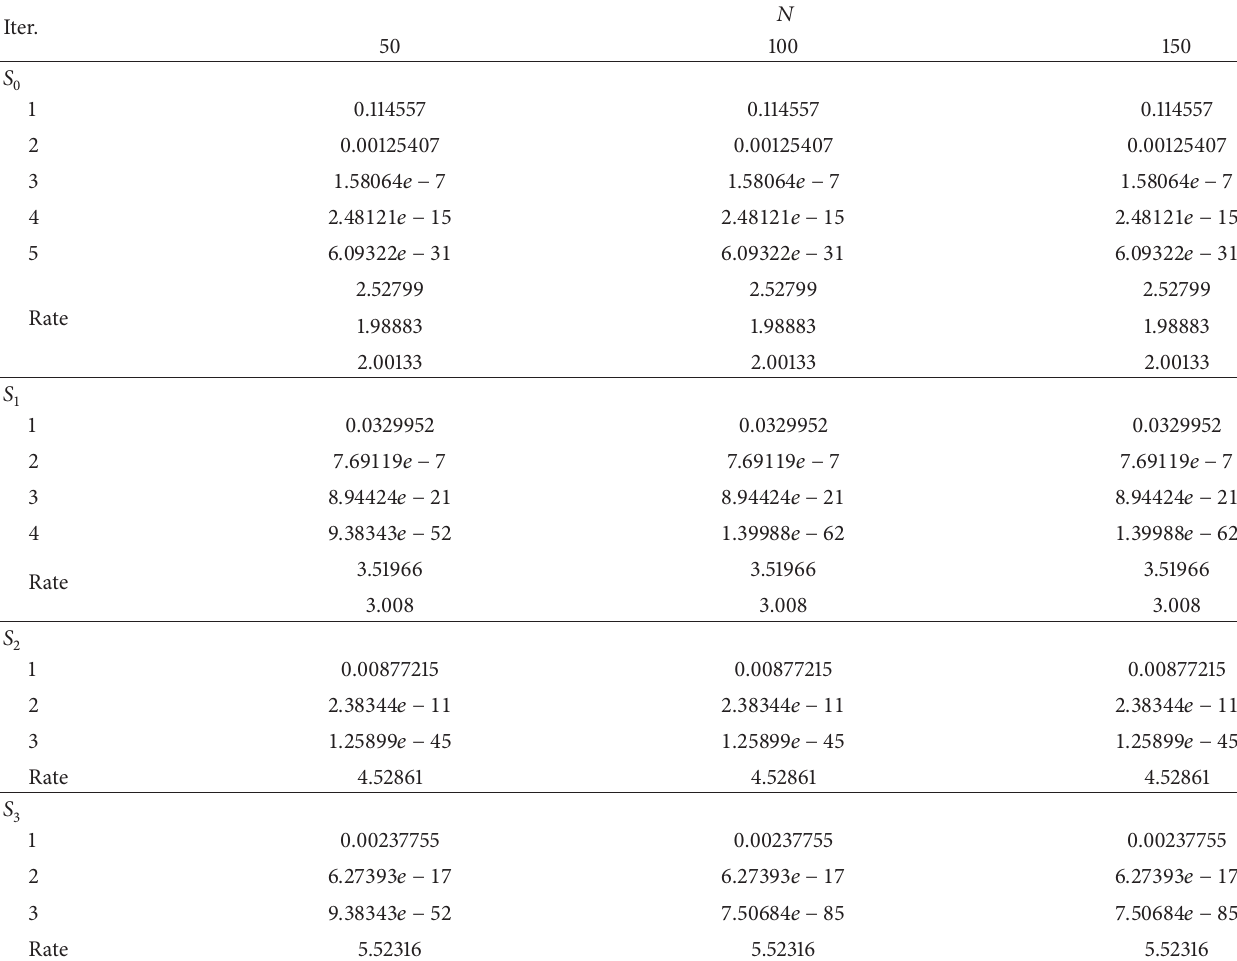
Table 4: Convergence order for Frank-Kamenetzkii problem for 𝑘 = 1 , 𝜆 = 1 and different values of 𝑁 . Iter.